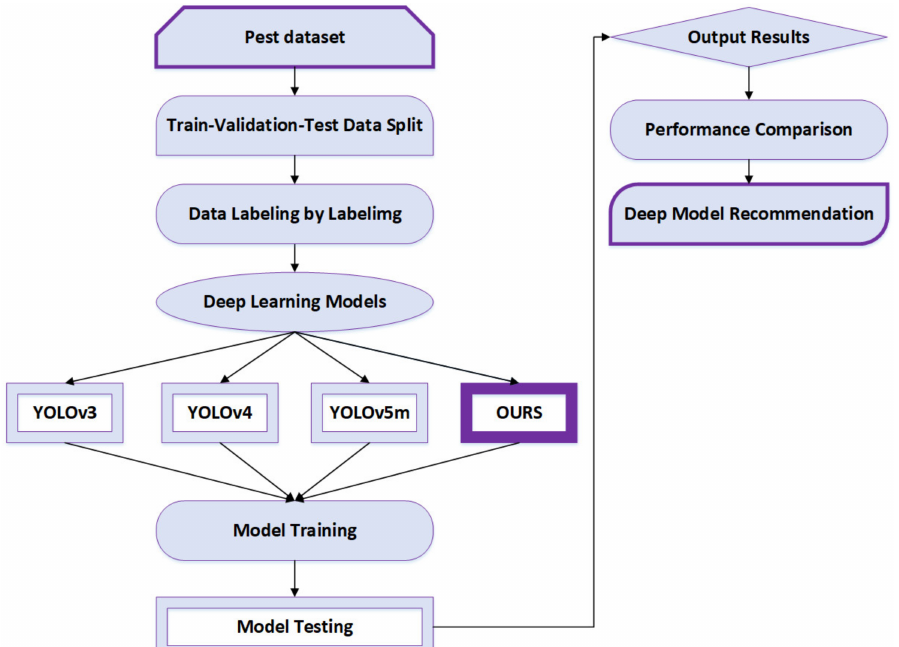
Figure 1. Overall flow chart of this work. It is composed of three important parts, i.e., pest dataset, deep learning model, and model testing. Pest dataset includes train, validation, and test data. Deep